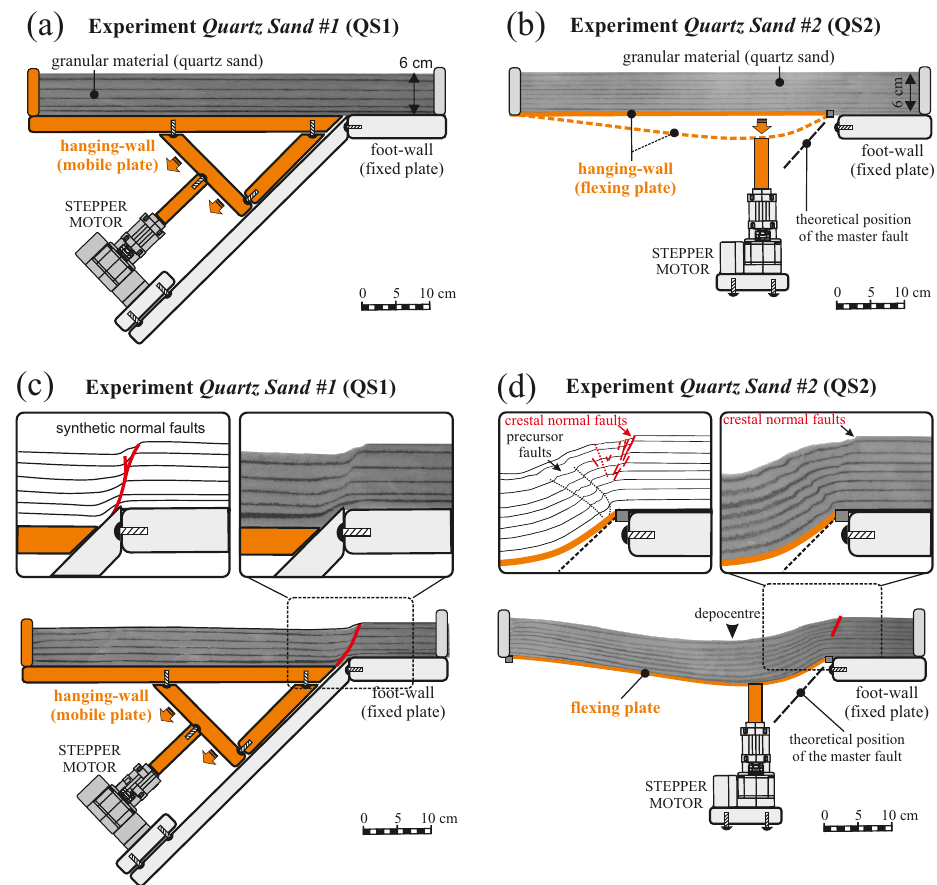
Figure 10. Analog modeling setup and results of dry sand experiments QS1 and QS2. (a) and (b) are sketches of the experimental modeling apparatus. (c) and (d) show the results of the experiment. Red lines represent newly formed faults and dashed black lines indicate precursor